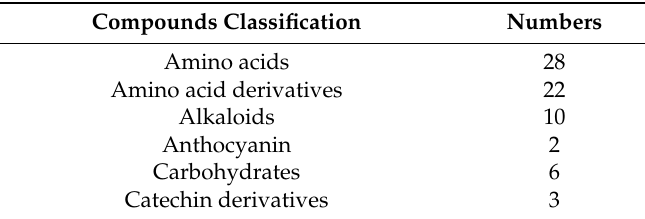
Table 1. Profile of